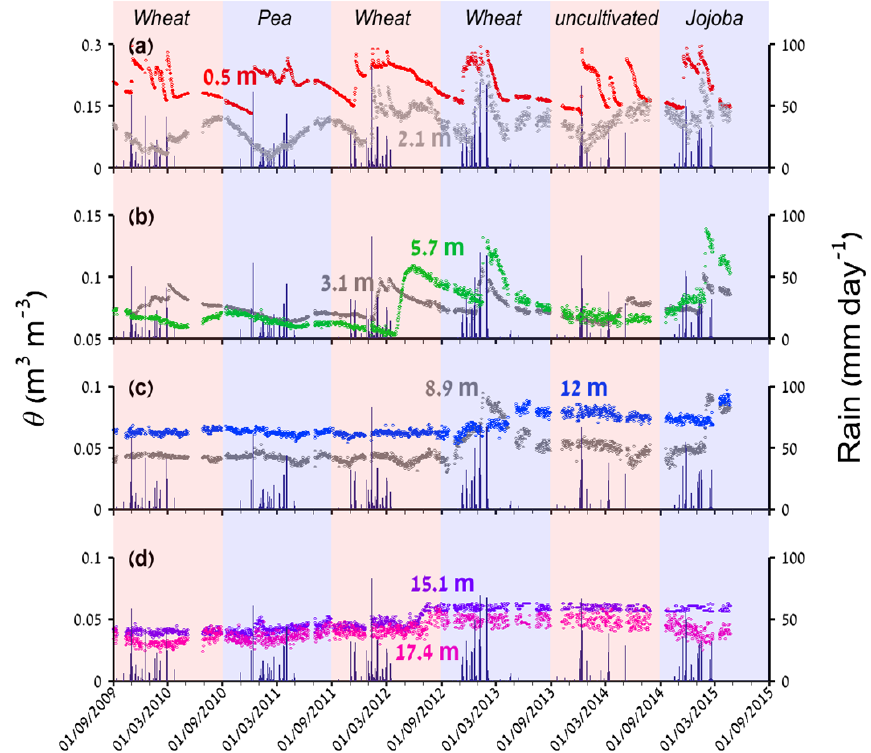
Figure 2. Water content ( θ) at different depths in the vadose zone and daily rainfall for 6 consecutive years.